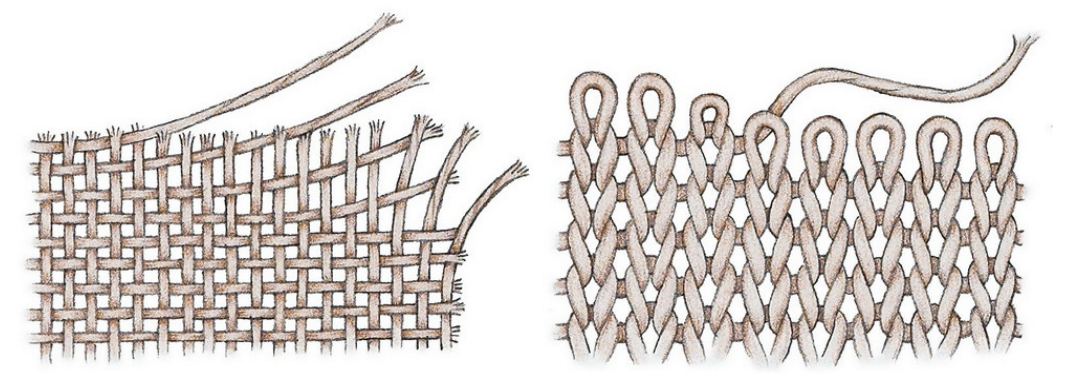
Figure 3. Image showing the structural difference between woven (seen left ) versus knitted (see right ) methods of fabrication of the polypropylene mesh, adapted from https://threadden.com/sew- ing-tips/the-difference-between-knits-wovens/ (accessed on 23 February 2023).